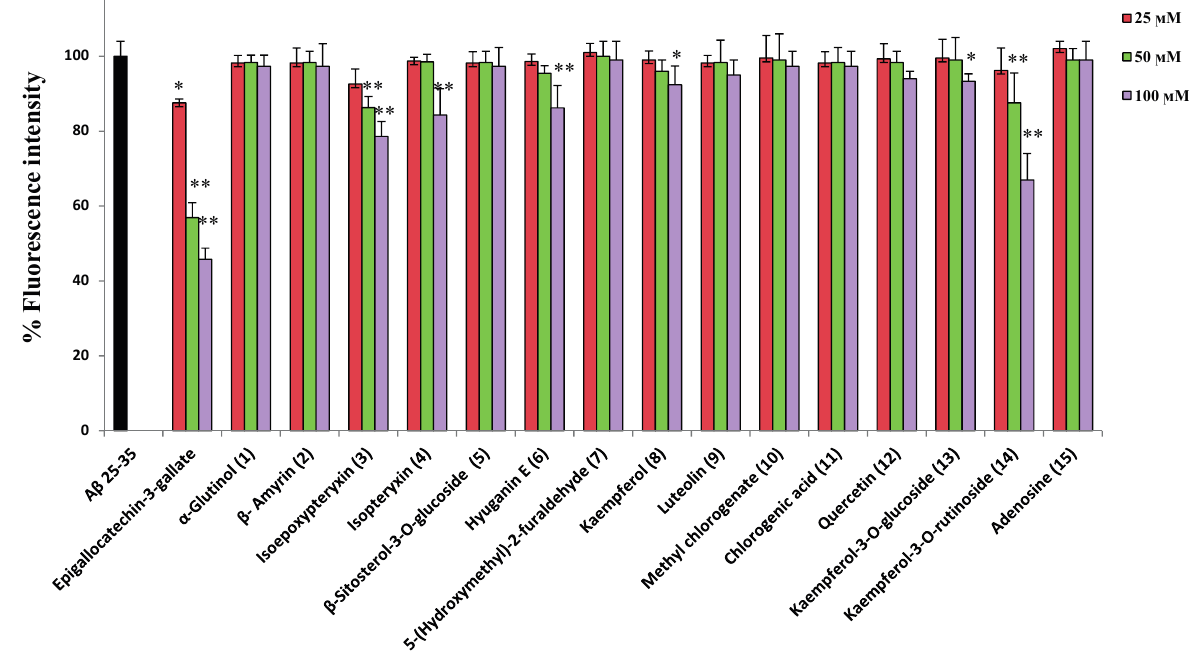
Figure 6. Effect of isolated compounds on A β 25-35 aggregation determined by measuring thioflavin T fluorescence. All values are means ± SDs ( n = 4). * and ** Significant